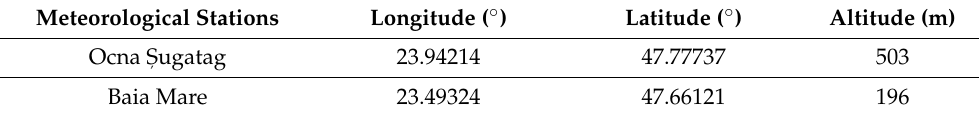
Table 1. The geographical coordinates of the meteorological